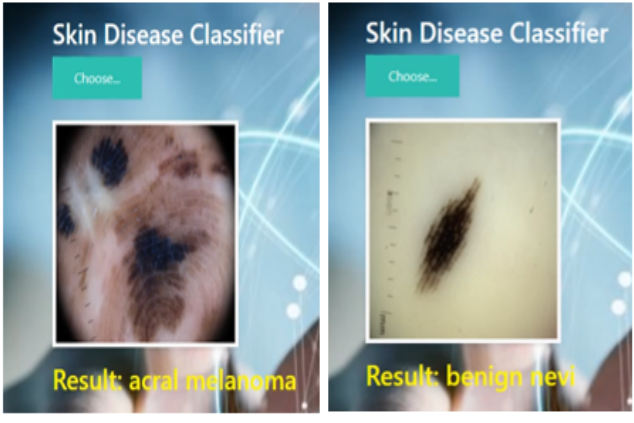
Figure 9. Sample classification results of pre-trained model.